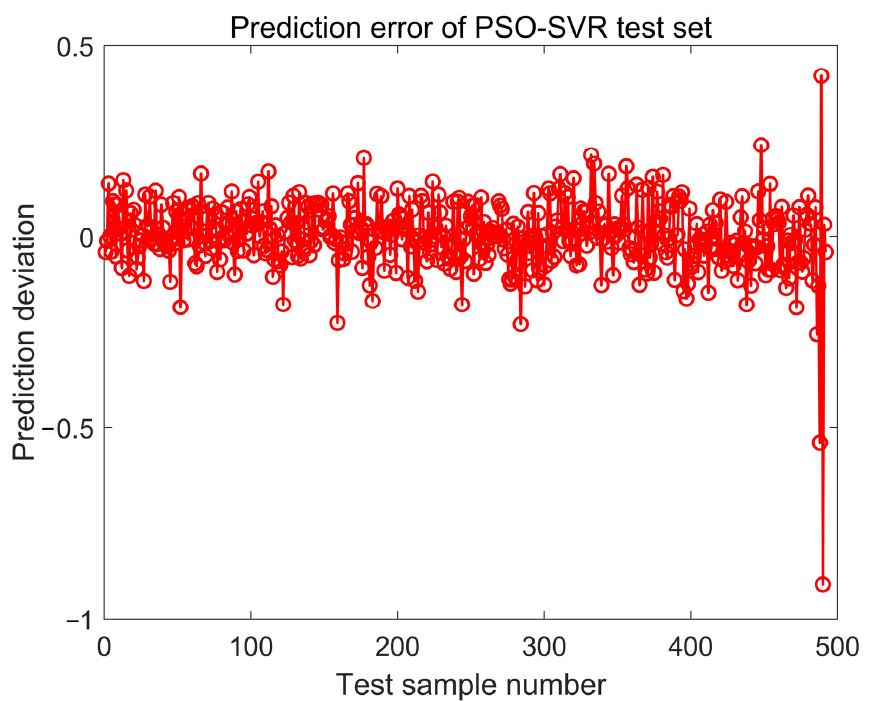
Figure 13. The prediction error of the test set by PSO-SVR.